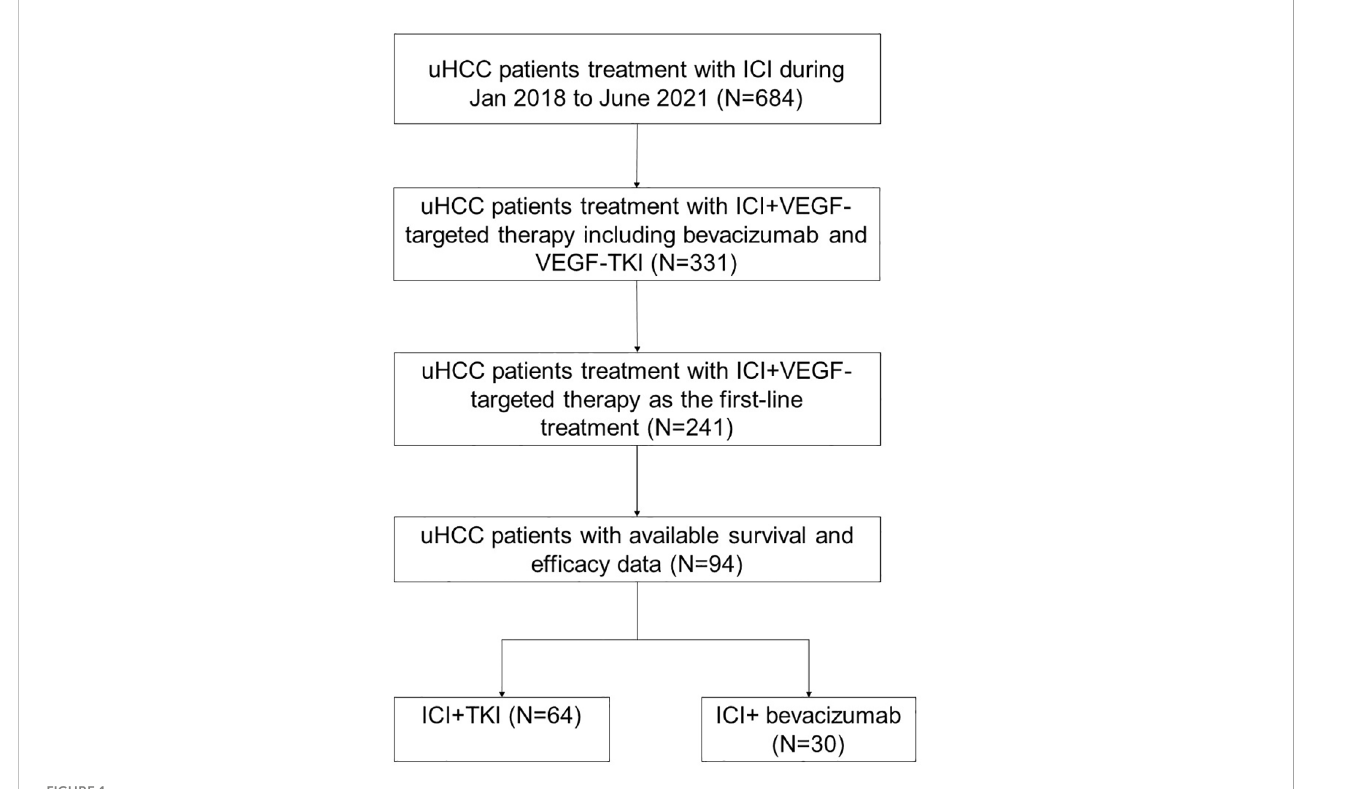
FIGURE 1 Trial pro fi